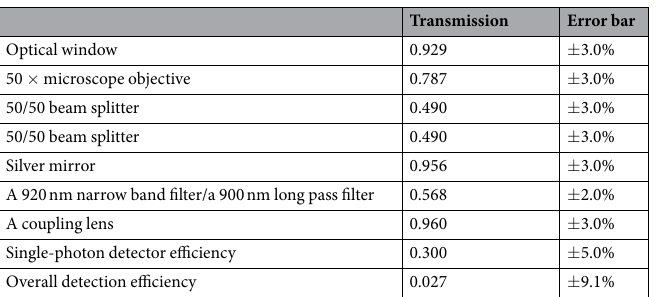
Table 1. Experimental set-up